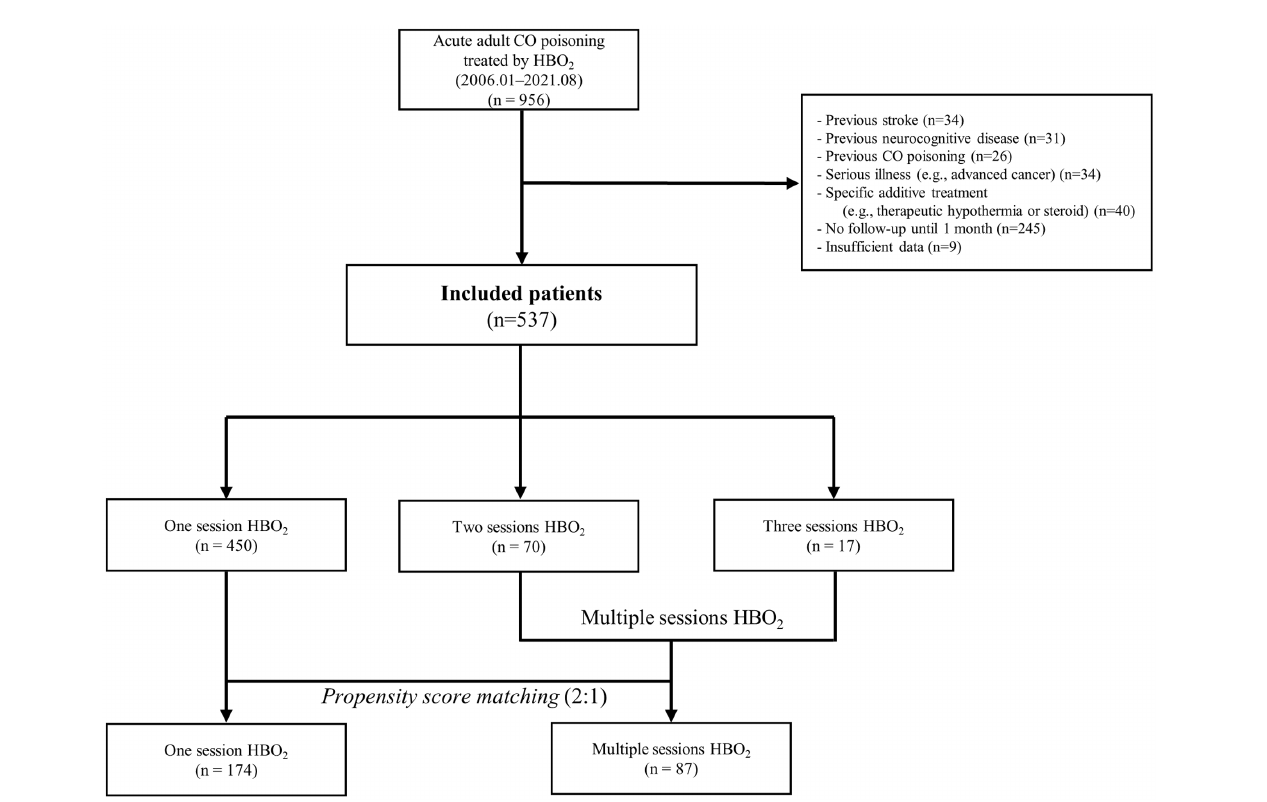
FIGURE 1 Study flow-chart. CO, carbon monoxide; HBO 2 , hyperbaric oxygen